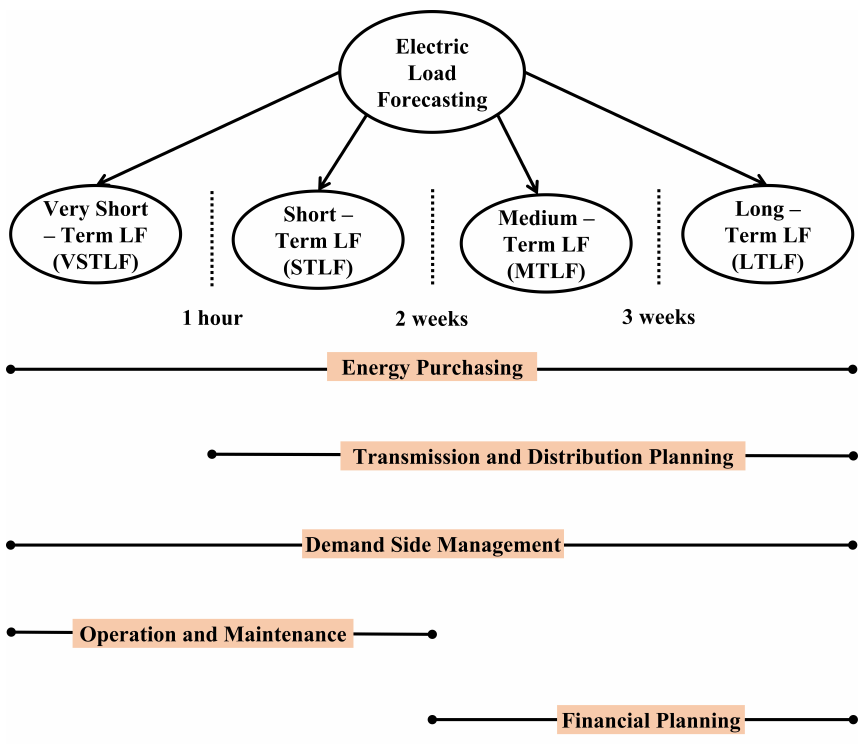
Figure 1. Types of load forecasting based on forecasting